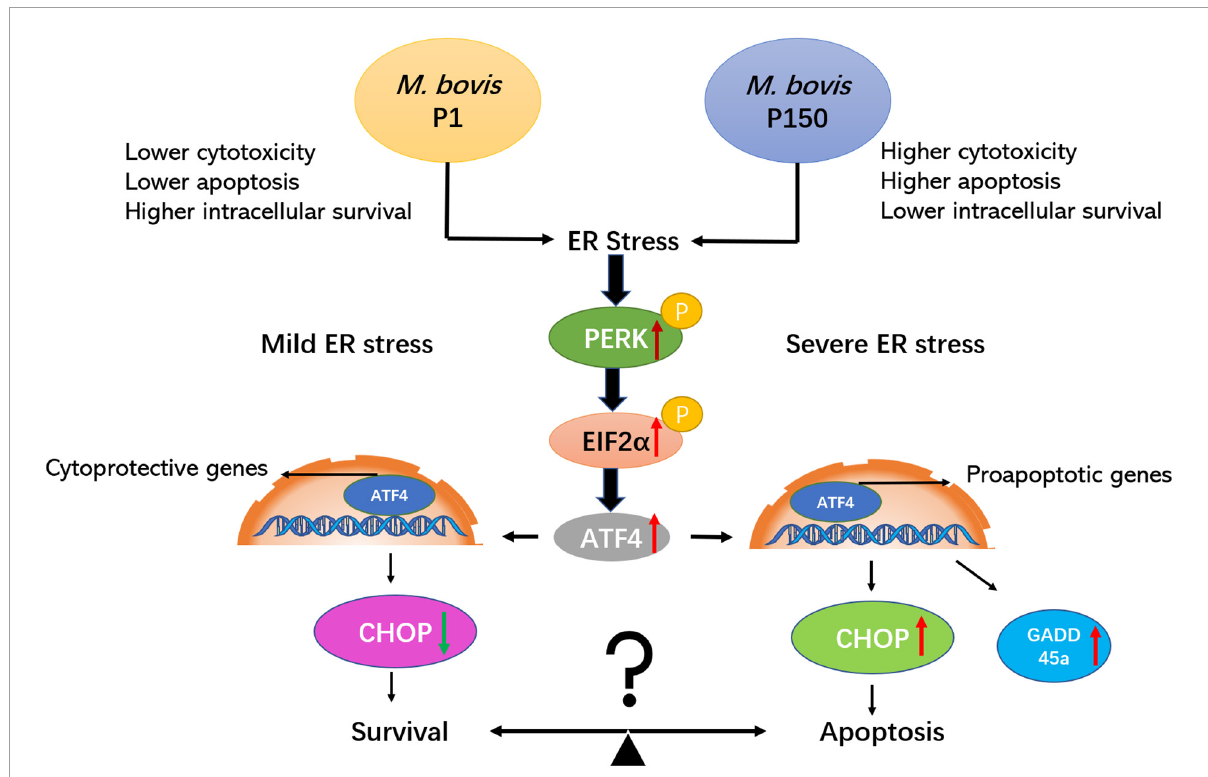
FIGURE7 The attenuated M. bovis strain P150 induces higher apoptosis of BoMac through a CHOP-upregulated mechanism via the protein kinase R-like endoplasmic reticulum kinase (PERK)-dependent signal pathway activation. After M. bovis P150 is infected, it induces an ER stress and activates phosphorylation of PERK and subsequently with the ability to phosphorylate EIF2 α . The result is the induction of ATF4 mRNA expression, which upregulates the expression of proapoptotic genes, e.g., CHOP and GADD45A. CHOP, the key downstream target of ATF4, as well as GADD45A, are upregulated and subsequently promoted apoptosis. Finally, the apoptosis of cell was increased that might be associated with a lower level of mycoplasma intracellular survival. The PERK/EIF2a/ATF4/CHOP/GADD45A axis is certainly involved in both survival and apoptotic signaling